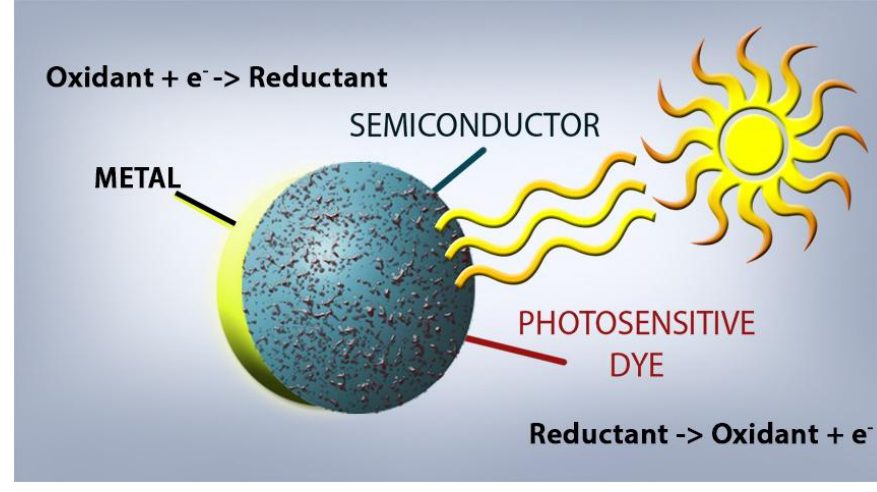
Figure 13. The above figure is a representation of a TiO metal coating on one side and a coating of photosensitive dye on the other. As the sunlight strikes the dye and oxidizes it, an electron transfers to the semiconductor. The use of these nanoparticles lowers the distance for the electron to transfer to the metal, reducing the recombination